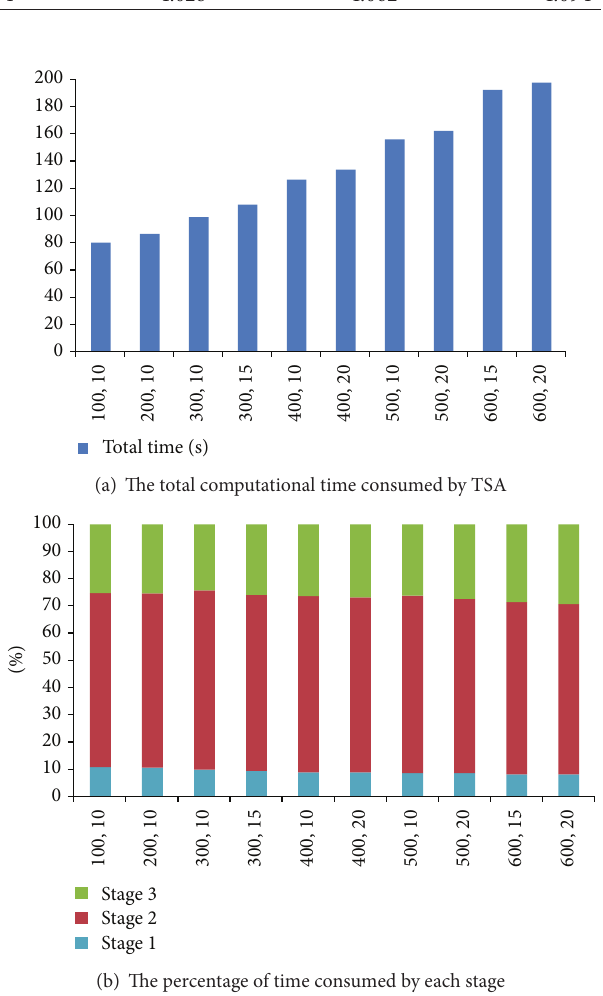
Figure 4: The computational time of